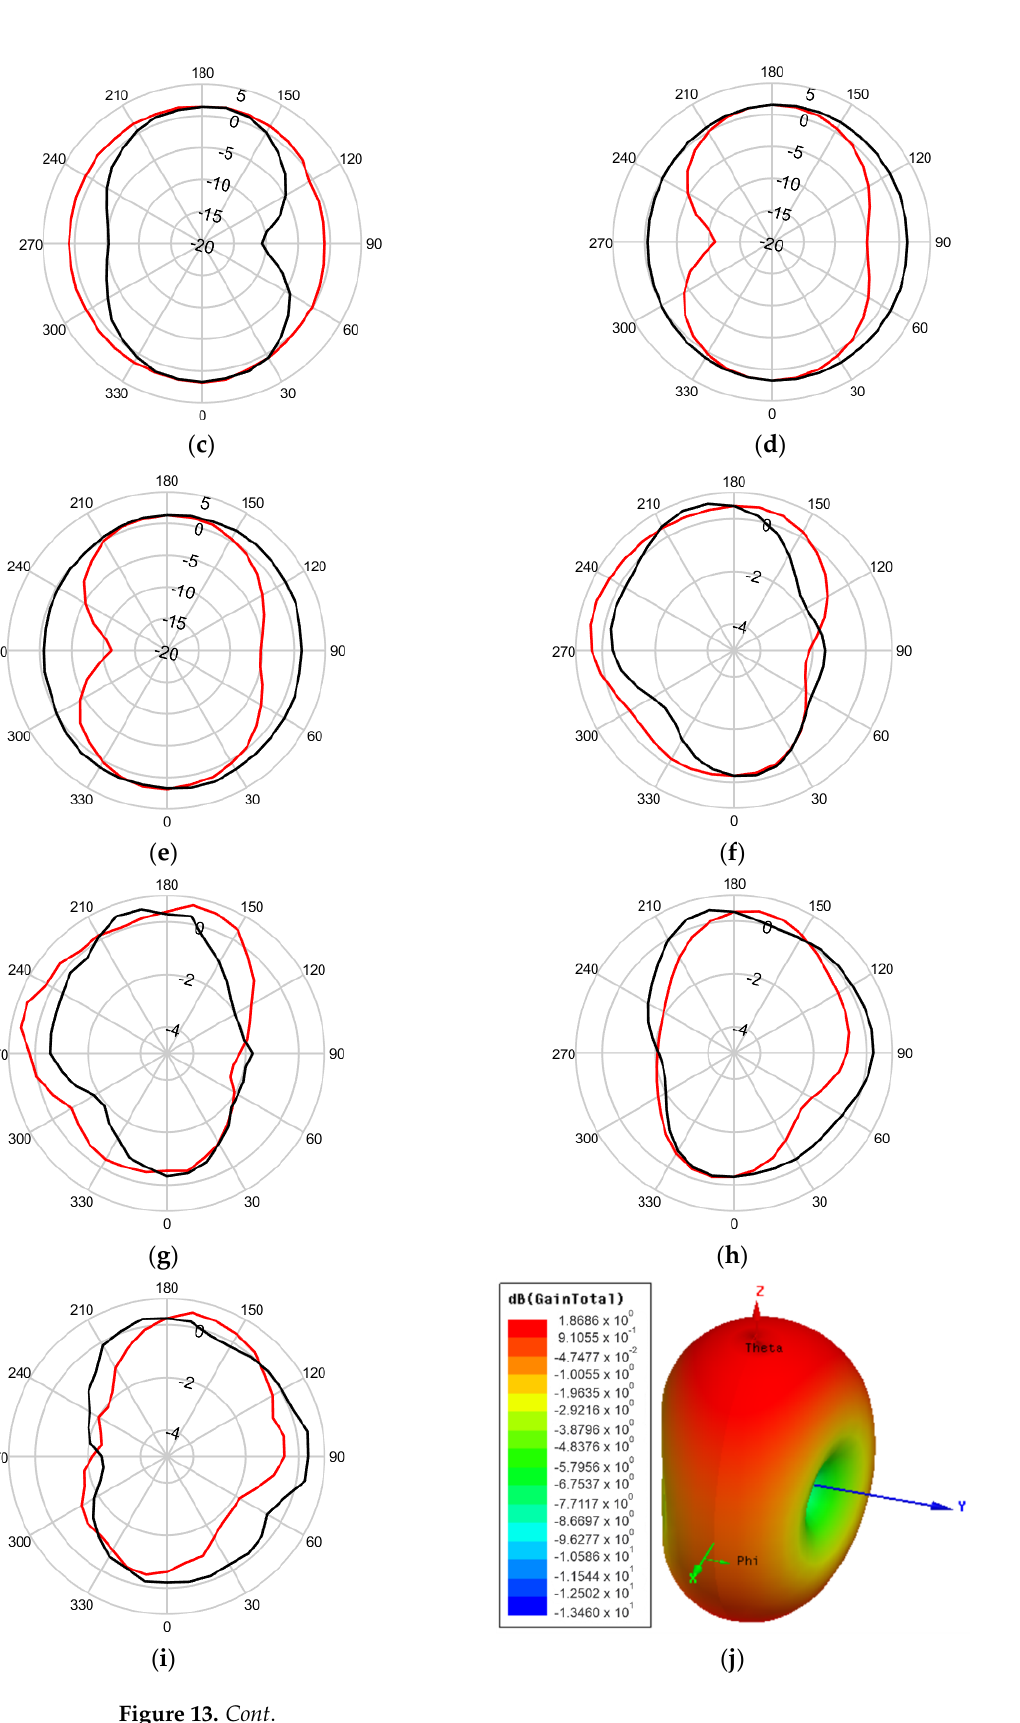
( b ) Figure 12. Dual-band MIMO antenna prototype: ( a ) top view and ( b ) bottom view. The MIMO antenna measurement setup is the same as shown in Section 2.4. The measured S-parameters and the 2-D radiation patterns at 3.5 and 5.45 GHz are presented in Figure 13, which are compared to the simulated results, showing a good agreement between them. As can be observed, the antenna exhibits a good impedance matching and isolations with more than 19.8 dB and 16.75 dB over the two operating bands, respectively.